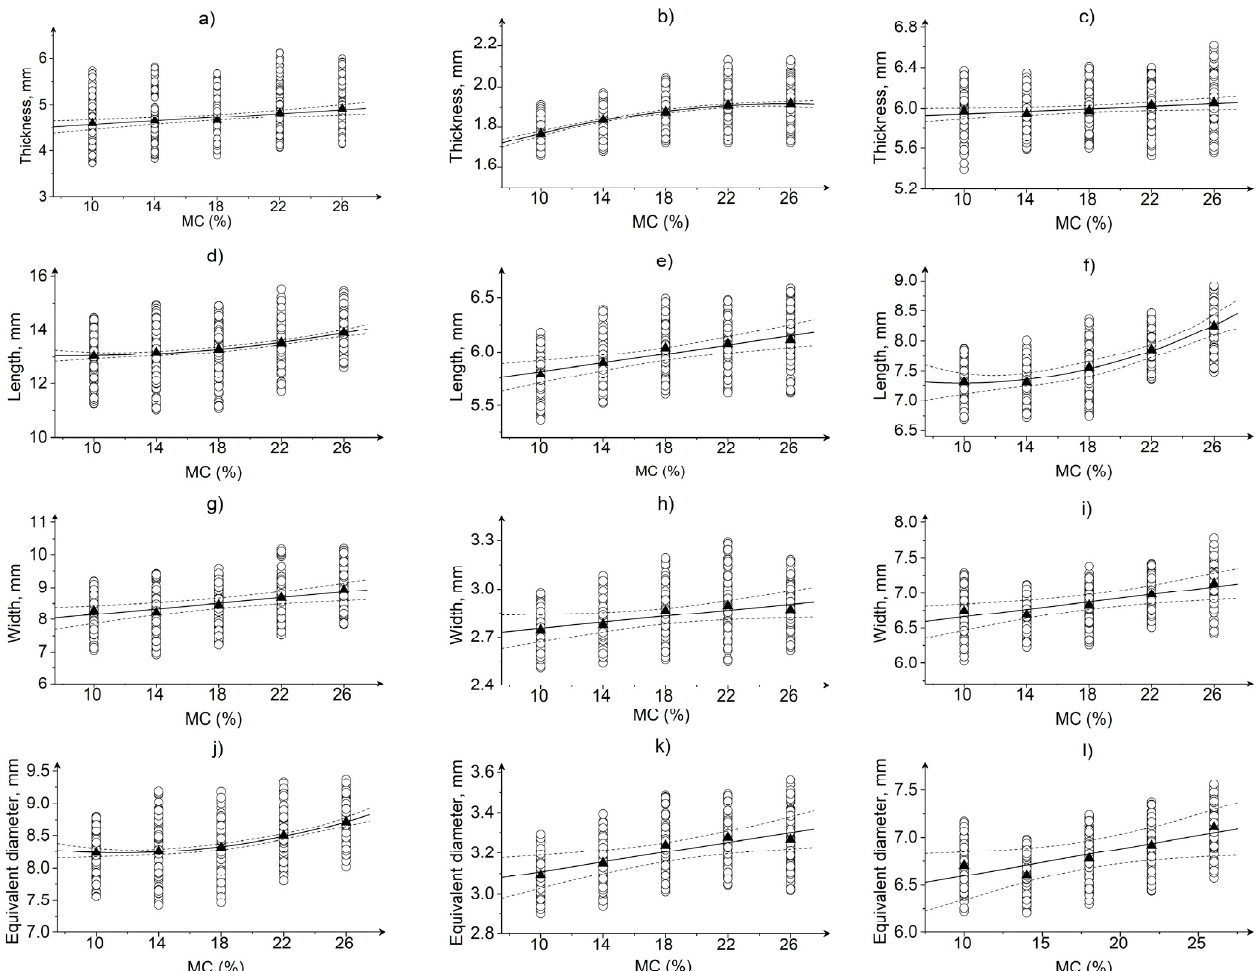
Figure 3. The dependencies between moisture content and thickness: ( a ) maize, T = 0.0205 MC + 4.438, R 2 = 0.923, ( b ) rice, T = − 5.95 × 10 − 4 MC 2 + 0.0306 MC + 1.522, R 2 = 0.999, ( c ) soybeans, T = 0.00602 MC + 5.887, R 2 = 0.786; length: ( d ) maize, L = 0.00272 MC 2 − 0.0463 MC + 13.253, R 2 = 0.996, ( e ) rice, L = 0.0209 MC + 5.605, R 2 = 0.928, ( f ) soybeans, L = 0.00374 MC 2 − 0.0736 MC + 7.747, R 2 = 0.994; width: ( g ) maize, W = 0.0448 MC + 7.700, R 2 = 0.895, ( h ) rice, W = 0.0925 MC + 2.663, R 2 = 0.796, ( i ) soybean, W = 0.0273 MC + 6.382, R 2 = 0.874; equivalent diameter: ( j ) maize, D e = 0.00233 MC 2 − 0.0534 MC + 8.536, R 2 = 0.997, ( k ) rice, D e = 0.0120 MC + 2.988, R 2 = 0.877, ( l ) soybeans, D e = 0.00283 MC + 6.314, R 2 = 0.808; ○ —data, ▲ —mean, ─ —fitted curve, ----—95% confidence band.